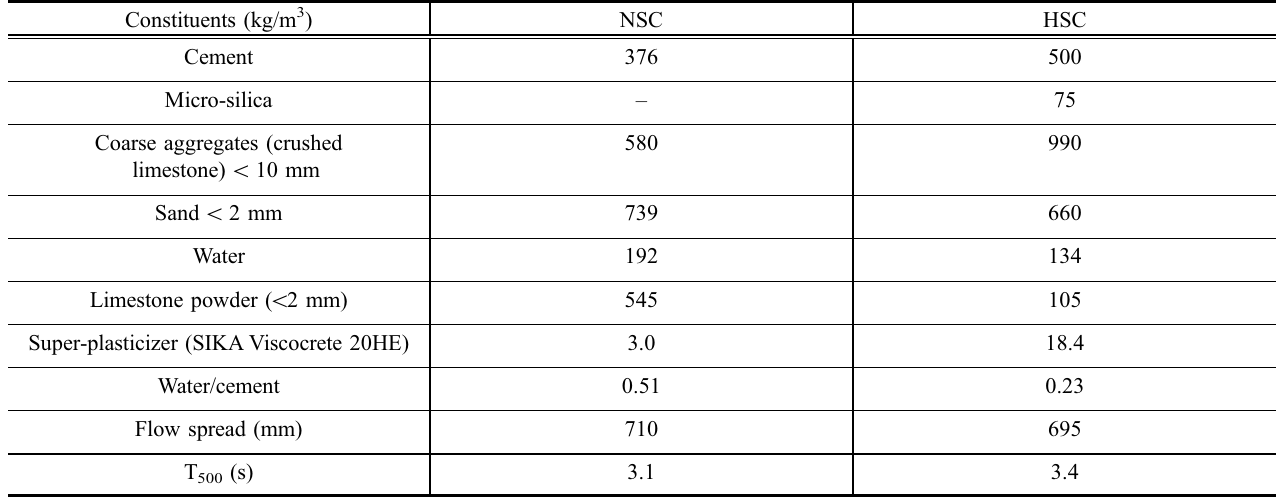
Table 1 Constituents and mix proportions for normal- and high-strength self-compacting concrete mixes.